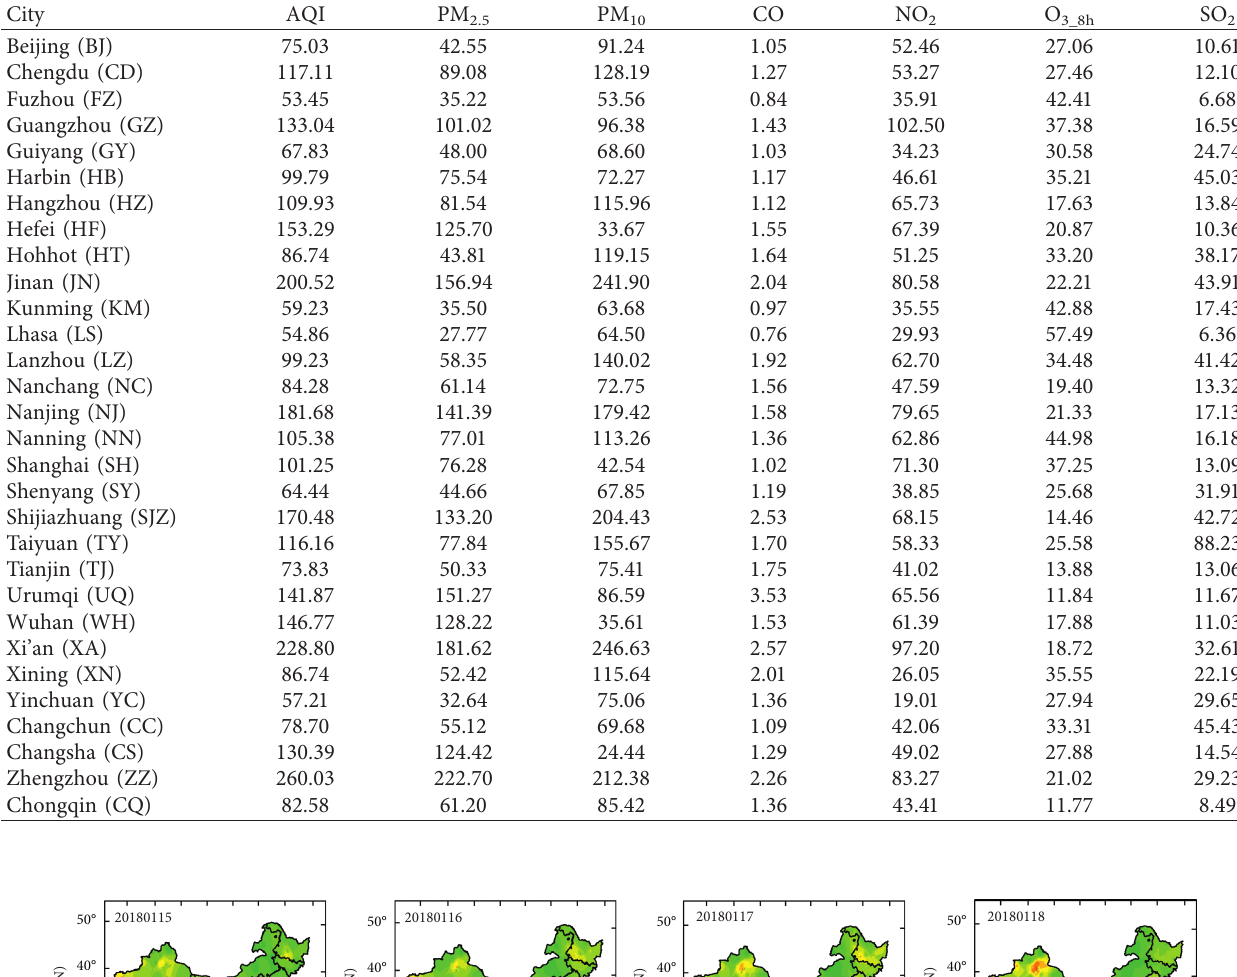
Table 2: Average concentrations of the air quality index (AQI) and six air pollutants in 30 provincial capitals in China during the pollution period (mg m − 3 for CO; μ gm − 3 for other pollutants).